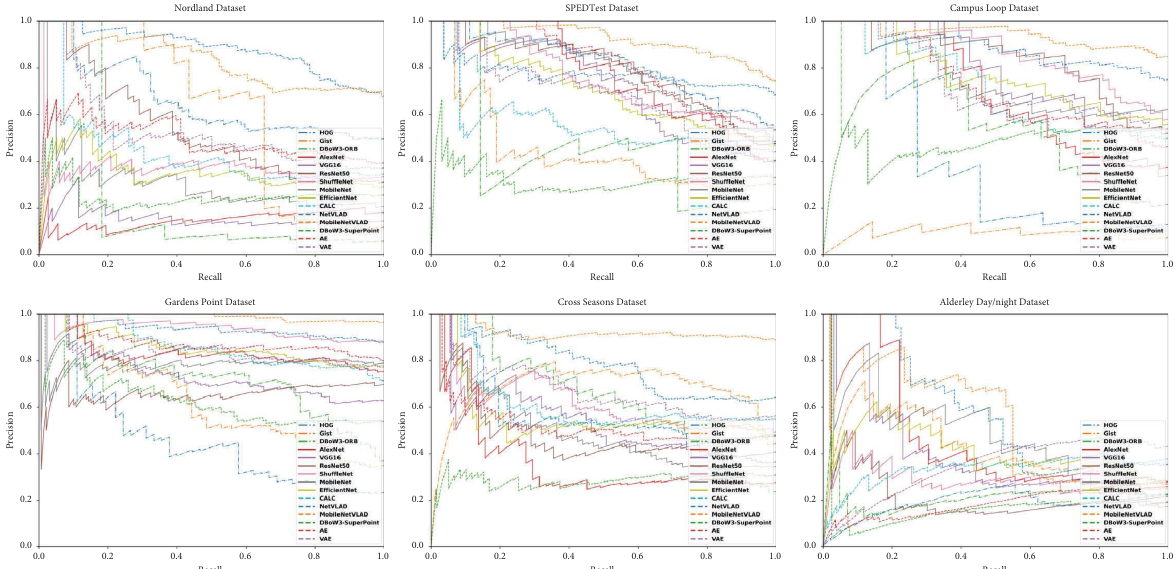
Figure 3: Te precision-recall curves for all 15 global descriptors generated on the 6 benchmark datasets. Table 3: Te values of AUC and R P100 for 3 handcrafted feature-based descriptors. Dataset